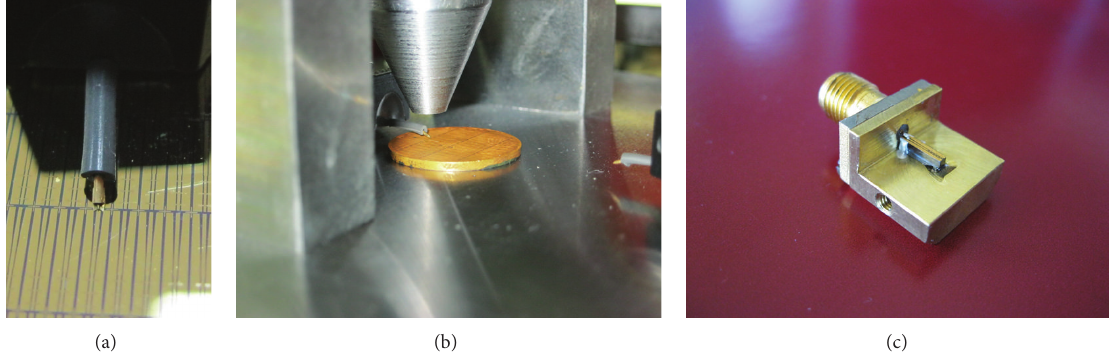
Figure 4: S¨uss Microtec probe-tip contacting a CRLH antenna structure supported by the ferrite wafer (a), the electromagnet providing the magnetic biasing field (b), and one of the antenna structures mounted on a test fixture (c).